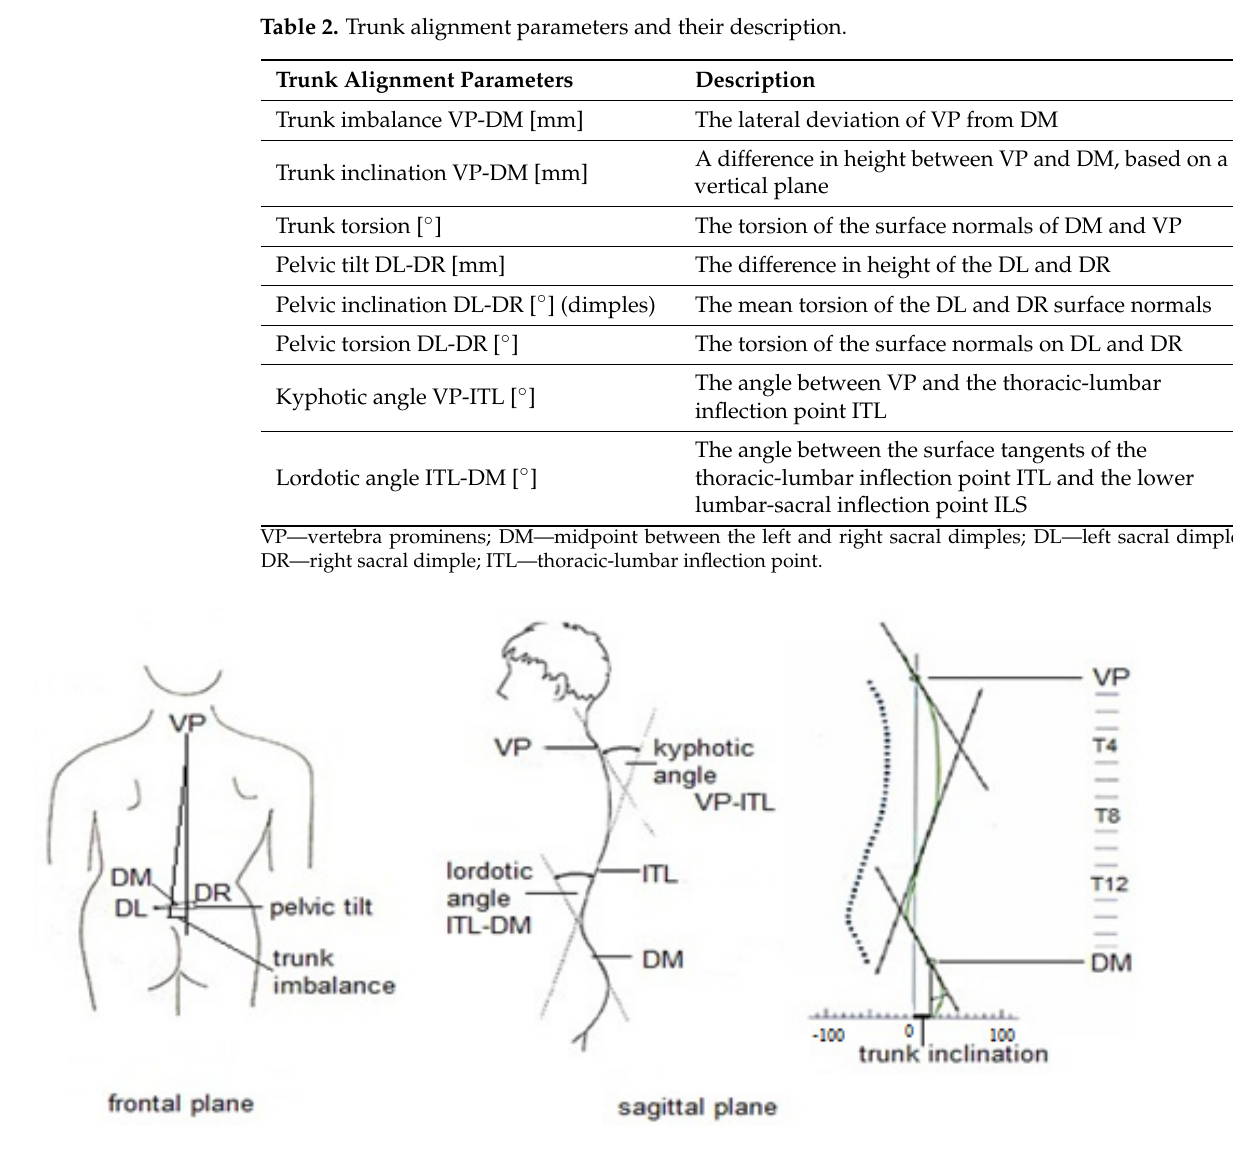
Figure 1. Trunk alignment parameters, measured with Diers Formetric. Abbreviations: VP—vertebra prominens; DM—midpoint between the left and right sacral dimples; DL—left sacral dimple; DR—right sacral dimple; ITL—thoracic-lumbar inflection point.